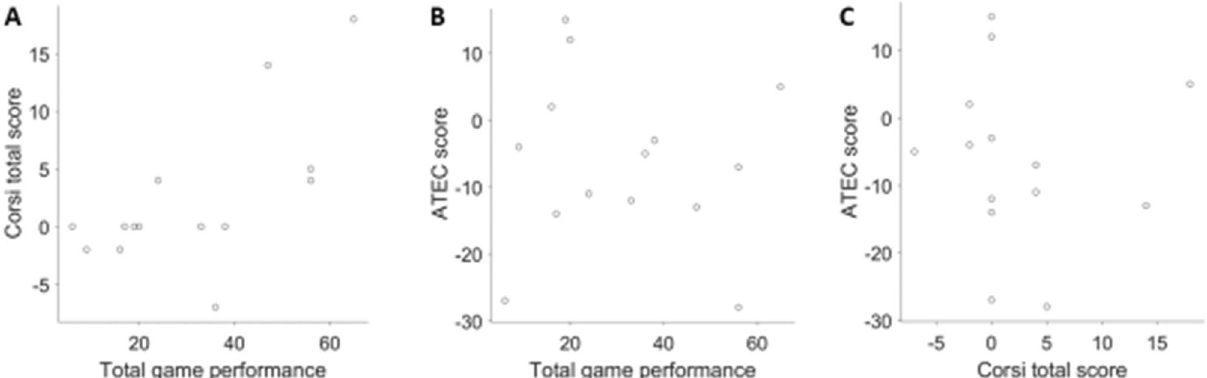
Figure 10. Performance on the games relates to improvements in working memory but not in autistic symptoms. ( A ) Scatter plot shows a positive correlation between the total game performance (the sum of maximum levels reached in different games) and the change in the Corsi total score with the intervention. ( B ) No correlation was seen between the total game performance and the change in the ATEC score. ( C ) Similarly, no correlation was observed between the change in the ATEC score and the change in the Corsi total